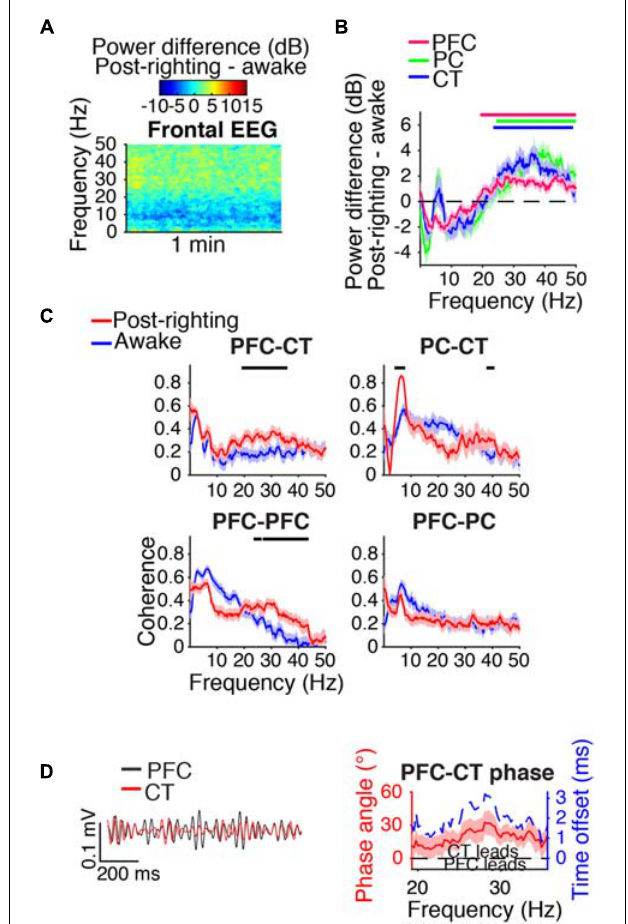
FIGURE 7 | Dynamics during the last minute of elevated slow-delta power. (A) Group difference spectrogram of the frontal EEG during the last minute of elevated slow-delta power. The same period is analyzed in (B–D) . (B) Group power difference for PFC (red), PC (green), and CT (blue) LFPs. Shading indicates 95% confidence intervals. Red, green, and blue horizontal lines mark ranges of significant power increase relative to awake baseline for PFC, PC, and CT LFPs, respectively. (C) Group coherence between LFPs during the awake baseline (blue) and last minute of elevated slow-delta power (red) states. Shading indicates 95% confidence intervals, and horizontal lines mark ranges of significant coherence increase from awake baseline. (D) Left: PFC (black) and PC (red) LFPs from a representative animal filtered in the range of significant PFC–PC LFP coherence increase within the slow-delta range shown in (C) . Right: Group PFC–PC LFP phase relationship shown for the range of significant PFC–PC LFP coherence increase shown in (C) , in terms of phase angle (left y -axis, red line) and time offset (right y -axis, blue dotted line). Shading indicates 95% confidence intervals for phase angle. A negative phase relationship indicates that the first signal leads the second.